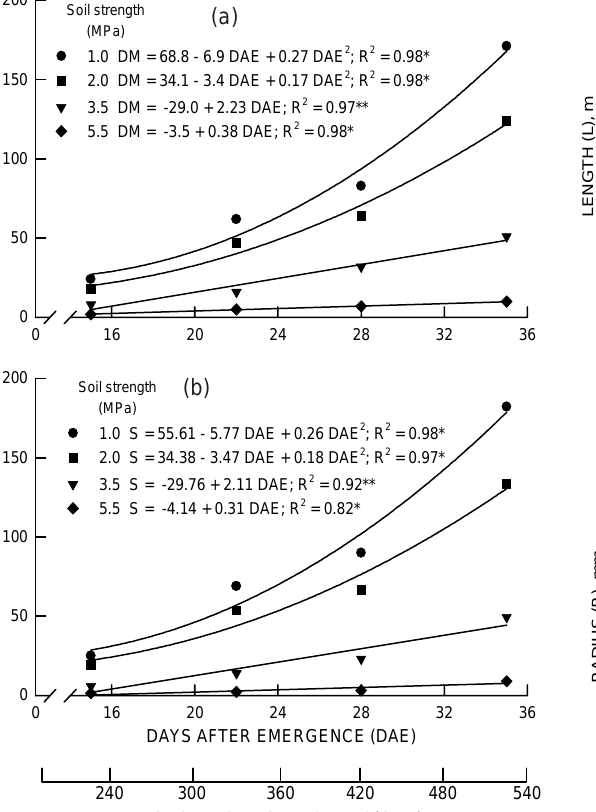
Figure 1. Wheat root dry matter (a) and surface (b) under different soil strengths.